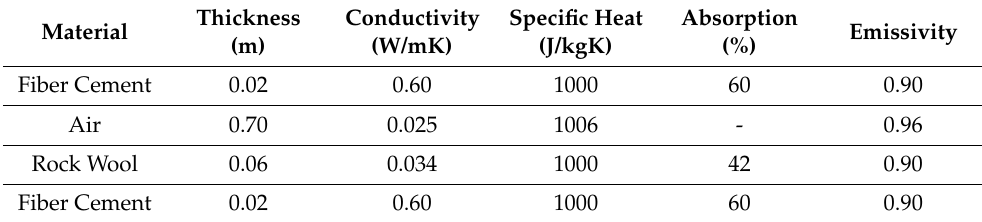
Table 5. Stratigraphy settings for the building roofs, using fiber-cement tiles.